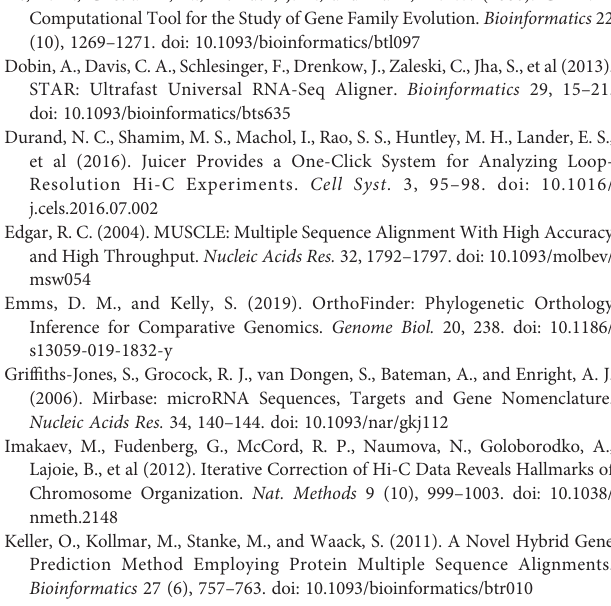
gene families compared with common ancestor ( Figure 1F ). The results of GO and KEGG analyses for expanded and contraction gene family and positive selection genes were shown in ( Supplementary Figures 5 – 7 ).